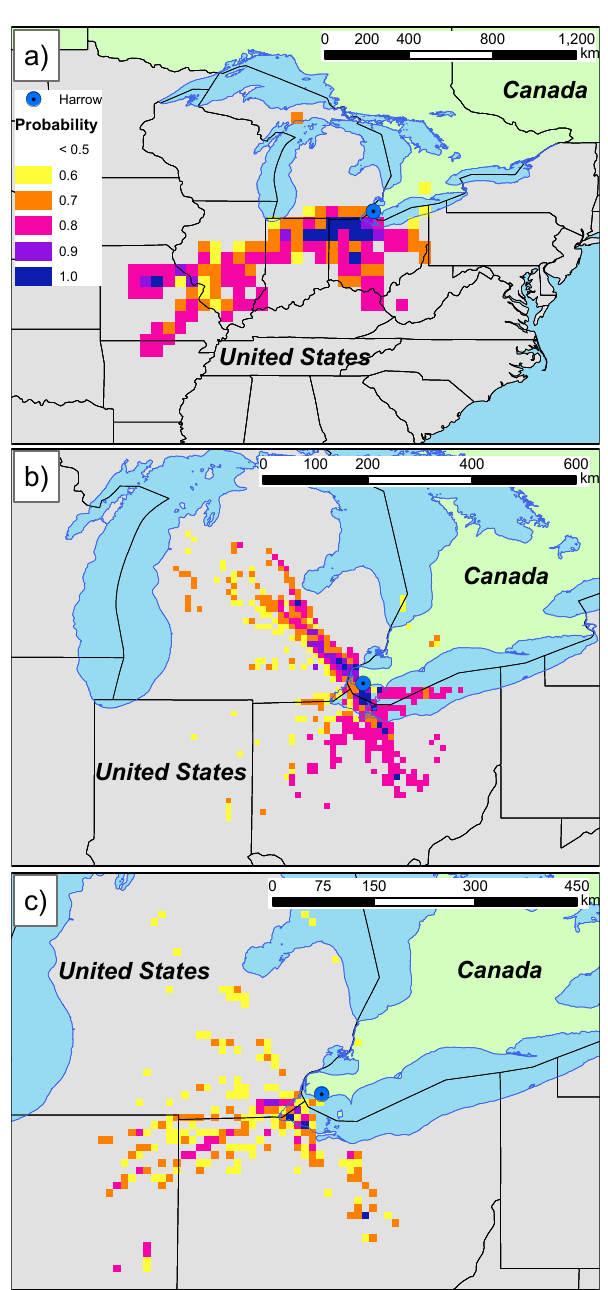
Fig. 6. Low resolution PSCF plot for the Long Range Transport factor (a) and high resolution PSCF plots for the Biomass Burning 2 (b) and ECOC Day (c) factors. Areas of higher probability indicate more probable source